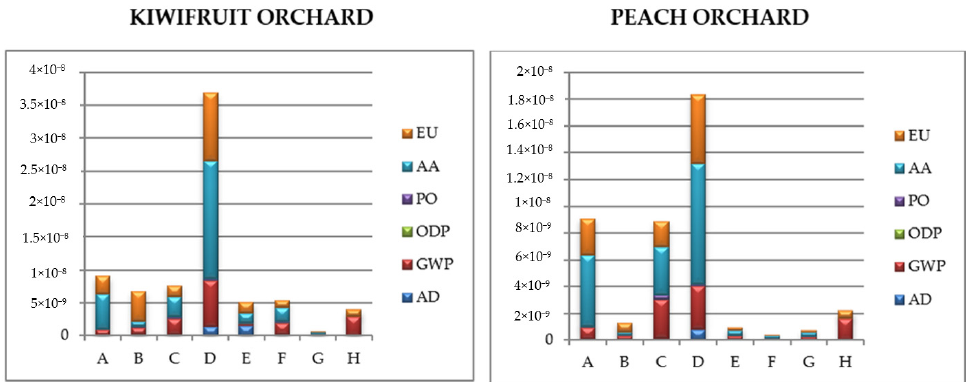
Figure 3. Contribution of the agricultural operations to the impact categories per kg of product obtained per year from each fruit orchard system. Normalization values. (A: Soil preparation; B: Plantation, irrigation system and supporting structures installation; C: Weed control and soil tillage; D: Fertilization; E: Diseases control; F; Harvesting; G: Trees explants; H: Crop residues EU: Eutrophication; AA: Air Acidification; PO: Photochemical oxidation; ODP: Ozone layer depletion; GWP: Global warming potential; AD: Abiotic depletion).